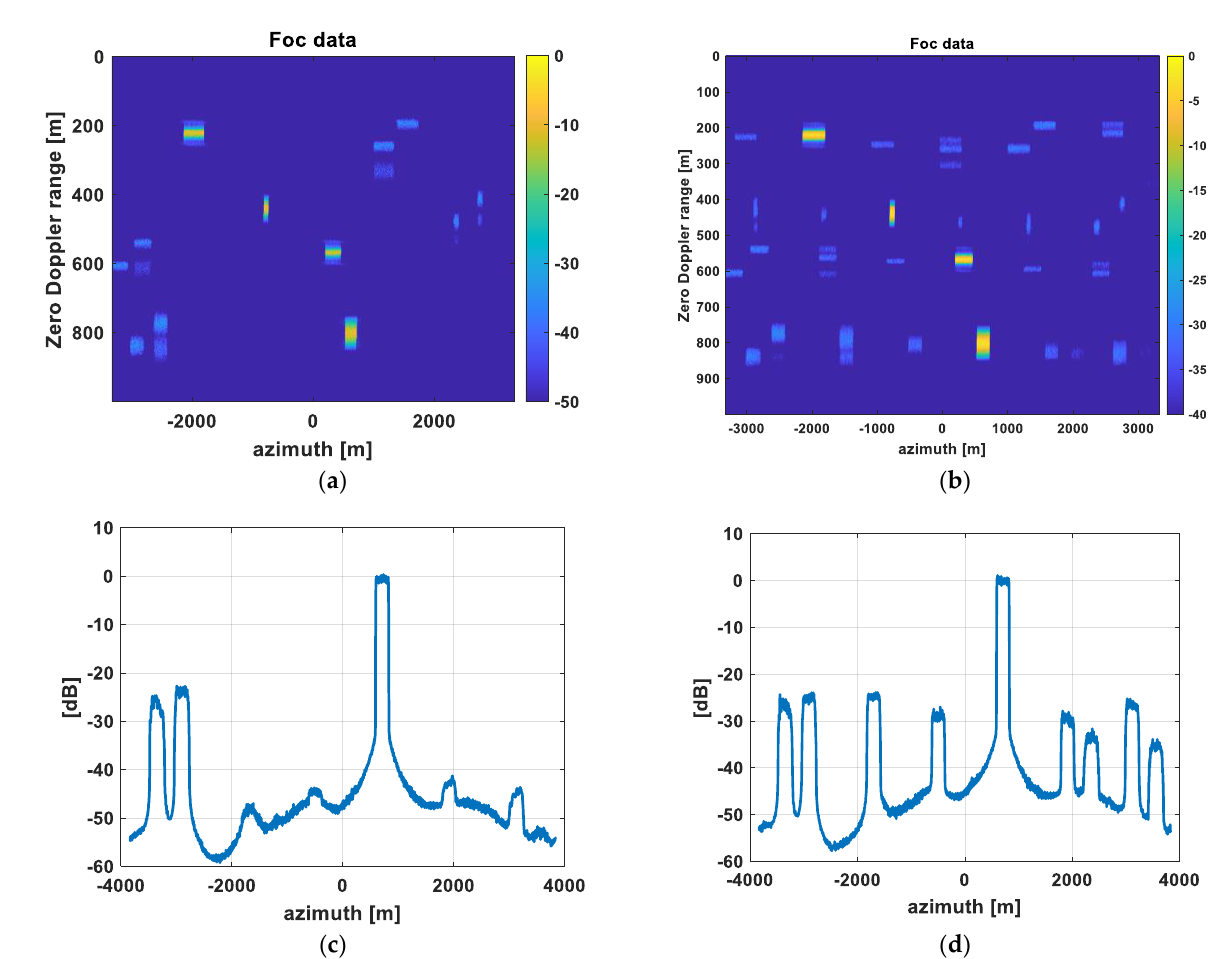
Figure 13. Amplitudes of multi-look, focused data, in dB, computed for the optimal sensors positioning, ( a ), and the not optimal one, ( b ). The two lower plots, ( c , d ), represent the first target’s energy integrated along the slant range for the two conditions.